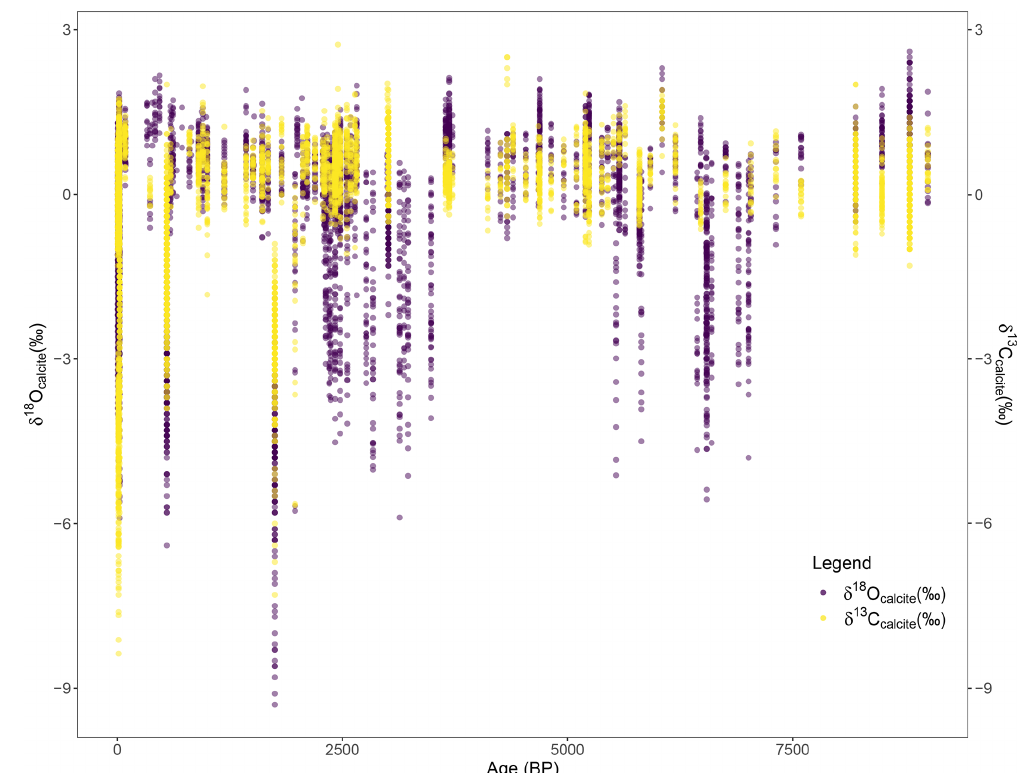
Figure 2. Oxygen (purple) and carbon (yellow) isotope values (‰ VPDB) through time in years before